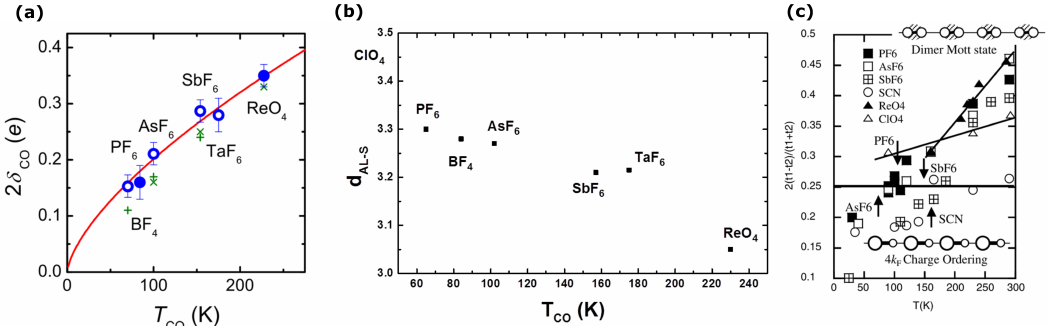
Figure 5. ( a ) Charge disproportionation 2 δ of the (TMTTF) 2 X salts with different anions X plotted versus the CO transition temperature T CO . The open circles [38,53] and closed circles [23] were determined by optical spectroscopy on the octahedral anions PF 6 , AsF 6 , SbF 6 , TaF 6 , and tetrahedral anions BF 4 and ReO 4 , respectively; the green crosses and green plus signs were measured by NMR [37,54,55] and Raman spectroscopy [38,56], respectively. The red line corresponds to 2 δ ∝ T 2/3 . CO Most important, all salts fall onto this line independent on the anion symmetry. ( b ) The shortest distance d AL − S between the sulfur atom of the organic molecule and the anion-ligand is evaluated at room temperature and plotted in dependence on the charge-order transition temperature T CO . All salts exhibiting CO fall on a line, indicating a linear decrease of T CO as the spacing d AL − S increases. ( c ) Temperature dependence of the bond dimerization 2 | t 1 − t 2 | taken from Reference [15], wherein the ( t 1 + t 2 ) transfer integrals t 2 and t 1 were obtained by applying the extended Hückel model on temperature dependent X-ray